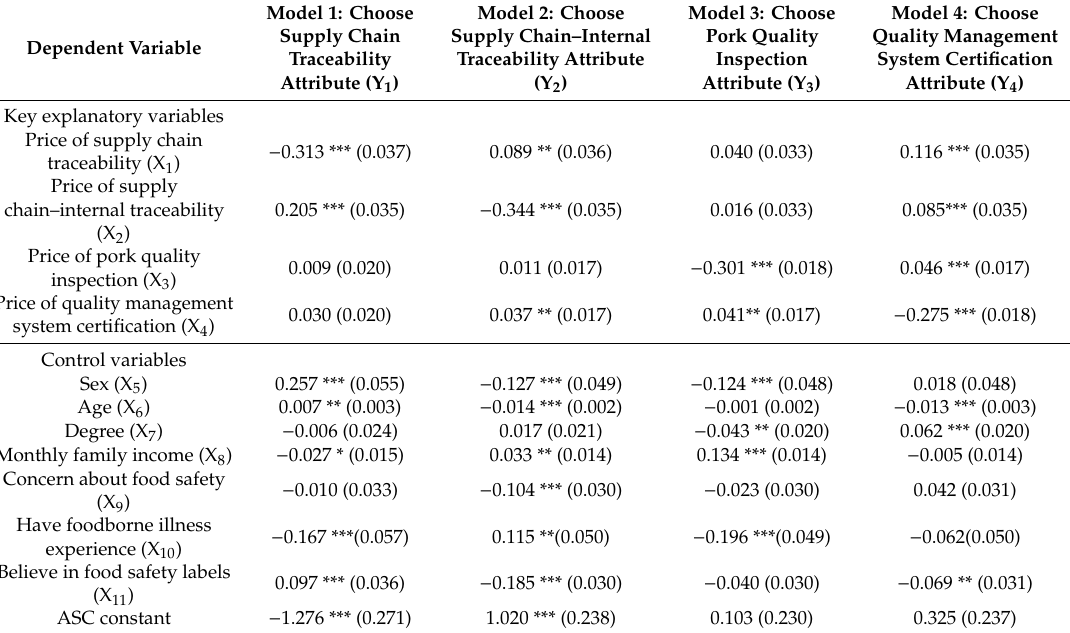
Table 10. Multivariate probit (MVP) model estimation results for each attribute